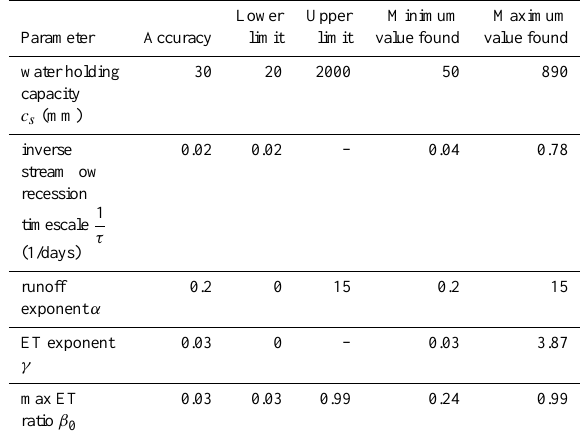
Table 1. Overview of model parameter accuracies, boundaries and the range of their respective